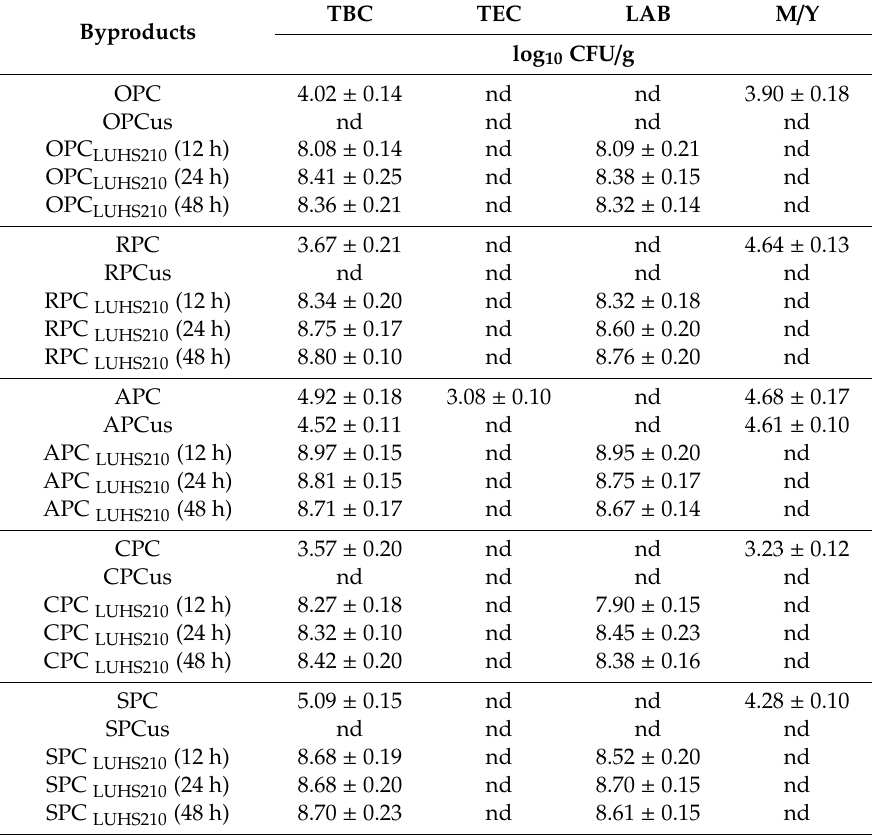
Table 2. Microbiological parameters (TBC—total bacteria count; TEC—total enterobacteria count; LAB—lactic acid bacteria; M / Y—mould / yeast) of 12, 24, and 48 h fermented and ultrasound treated